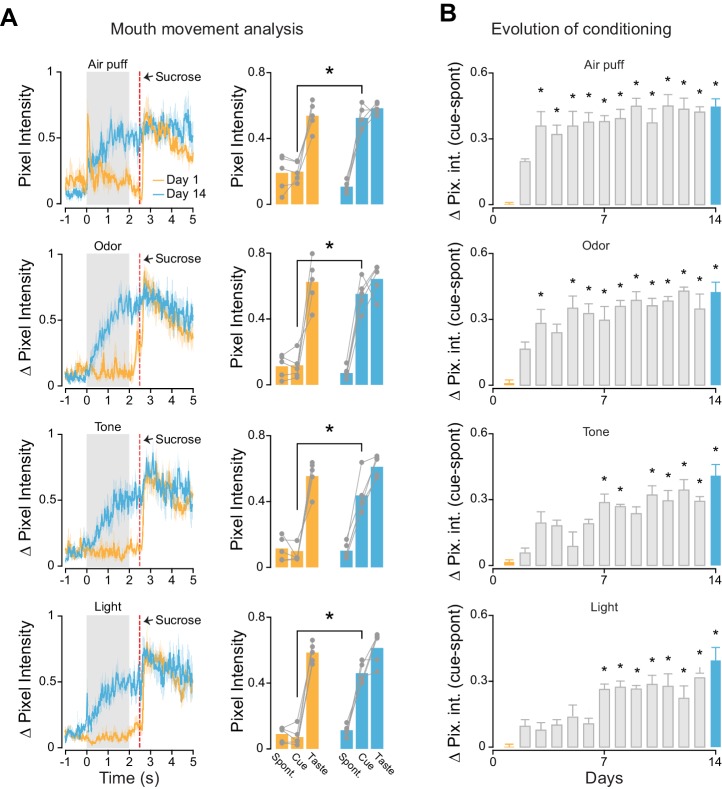
Associative learning for different cross-modal stimuli.(A) Left most panel: Average time course of orofacial movements evoked by cross-modal cues and sucrose during the first (gold) and 14th (cyan) day of classical conditioning (n = 5 rats). Shaded grey area and red dotted line indicate cues and sucrose presentation respectively. The shaded area around the curve represents ± SEM. Right most panel: average across trained rats (n = 5) of mouth movements (assessed by changes in pixel intensity) in different temporal epochs (1 s before cue onset [−1 to 0 s; Spont.], 1 s after cue onset [0.5–1.5 s; Cue] and 1 s after sucrose onset [2.7–3.7 s; Taste]) for the first (gold) and 14th (cyan) day of classical conditioning. (B) Average (n = 5 rats) of mouth movements across the 14 conditioning days. For A and B: asterisks indicate post-hoc tests corrected for multiple comparisons (Tukey, p<0.05). Rows from 1 to 4 show the orofacial activity evoked by air puff, odor, tone and light respectively.DOI:
http://dx.doi.org/10.7554/eLife.16420.00610.7554/eLife.16420.007Figure 2—source data 1.Values of the orofacial movements evoked by the cross-modal stimuli.